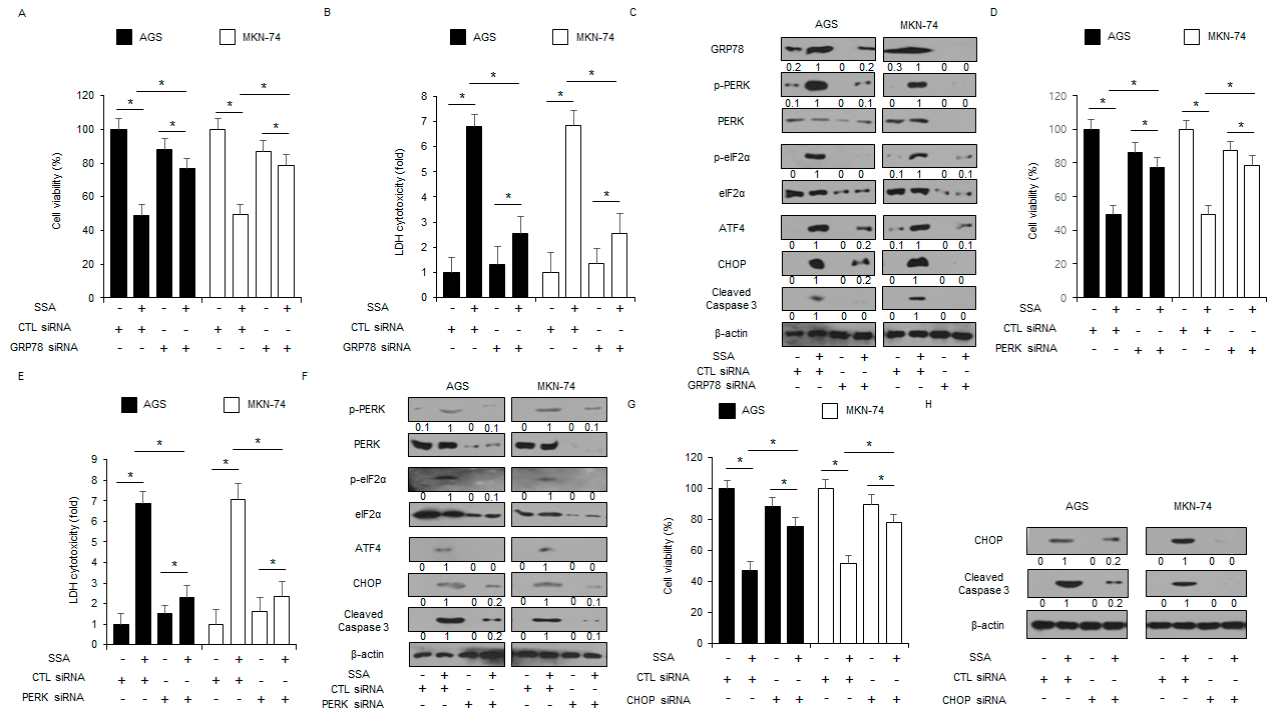
Figure 4. Targeting ER stress inhibits SSA-induced apoptotic cell death in GC cells. ( A – C ) AGS and MKN-74 cells were transfected with GRP78 siRNA with SSA treatment (10 µ M, 24 h). Then, cell viability, LDH release, and GRP78, p-PERK, PERK, p-eIF2 α , eIF2 α , ATF4, CHOP, and cleaved caspase-3 levels were determined; *, p < 0.05. β -actin was used as a protein loading control. ( D – F ) Cell viability, LDH release, and p-PERK, PERK, p-eIF2 α , eIF2 α , ATF4, CHOP, and cleaved caspase-3 levels in AGS and MKN-74 cells treated with SSA (10 µ M, 24 h) were determined in the presence or absence of PERK siRNA (30 nM, 24 h); *, p < 0.05. β -actin was used as a protein loading control. ( G , H ) Cell viability and Western blot analyses for CHOP and cleaved caspase-3 in AGS and MKN-74 cells treated with SSA (10 µ M, 24 h) were performed in the presence or absence of CHOP siRNA (30 nM, 24 h); *, p < 0.05. β -actin was used as a protein loading